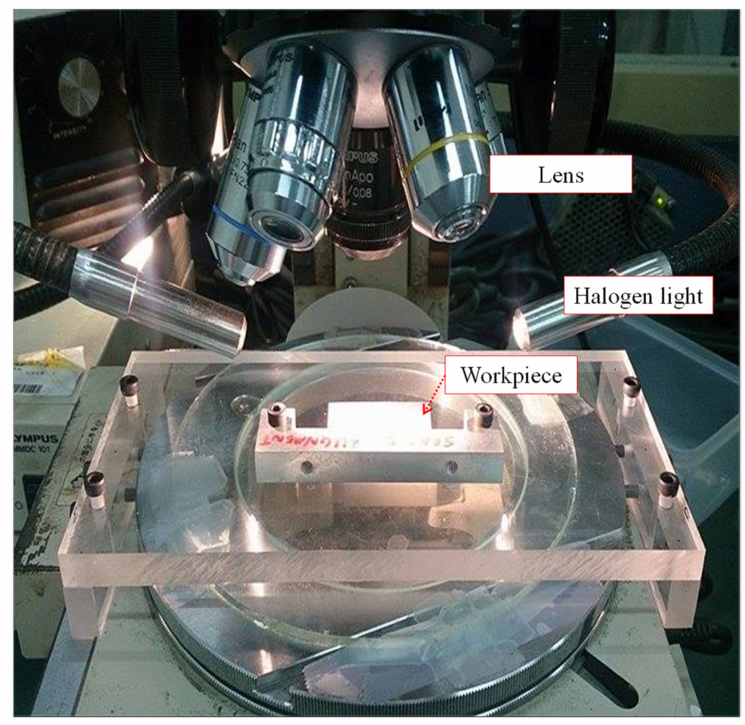
Figure 2. OLYMPUS U-PMTVC 8C14561 tool microscope.